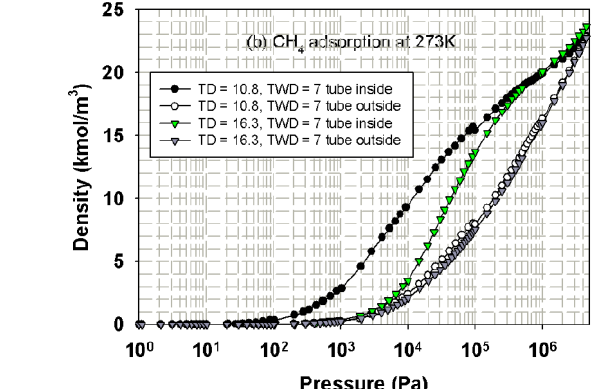
Figure 12. Snapshots of CO 2 in 6.3, 9 and 20 Å pores at 273